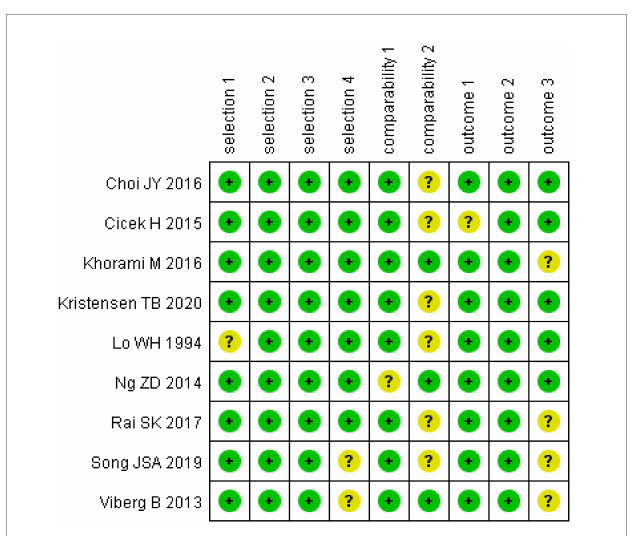
FIGURE3 Risk of bias assessment of observational